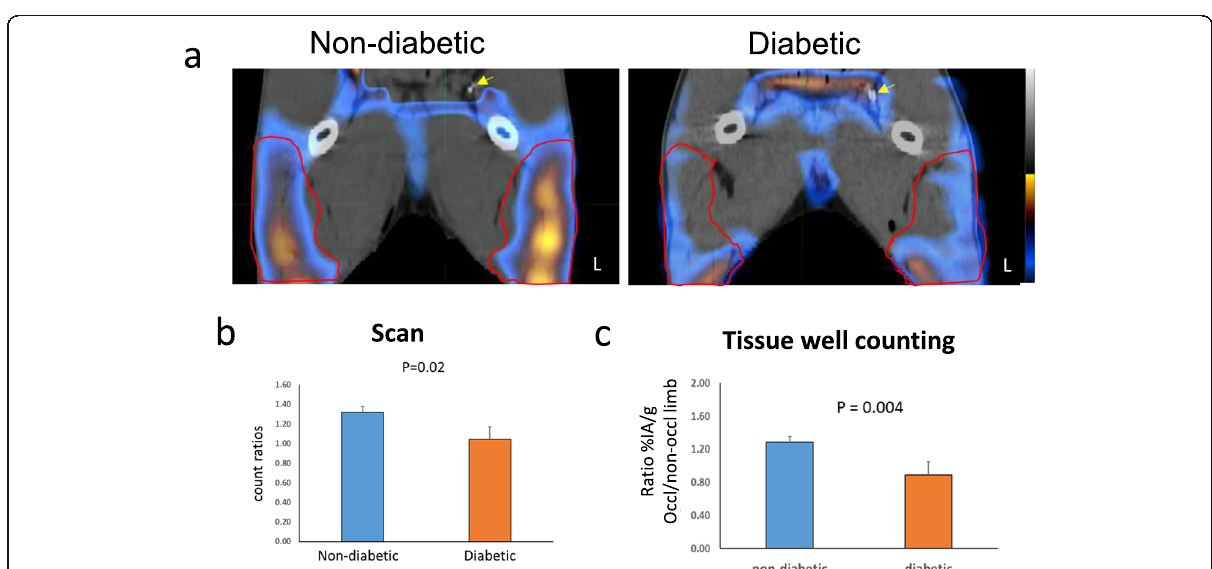
Fig. 3 a scV/Tc SPECT/CT scans from day 7 after FAO for a non-diabetic pig on the left and a diabetic pig on the right. Yellow arrows identify the occluder on the CT scan. Red outlines show borders of the proximal gastrocnemius muscle identified on the CT. The color scale bar represents counts/unit time. The bladder was removed, and the upper threshold reduced equally in both images to about 50% of peak counts to visually bring out the muscle uptake. The raw counts derived from the images were moved to spread sheet to convert to %IA (see text). b Bar graphs of mean ± SD of ratios of tracer uptake (%IA/cc) between the two limbs taken from gastrocnemius regions. c Bar graph of ratios for %IA/g between the two limbs measured from semimembranosus biopsy specimens taken immediately prior to